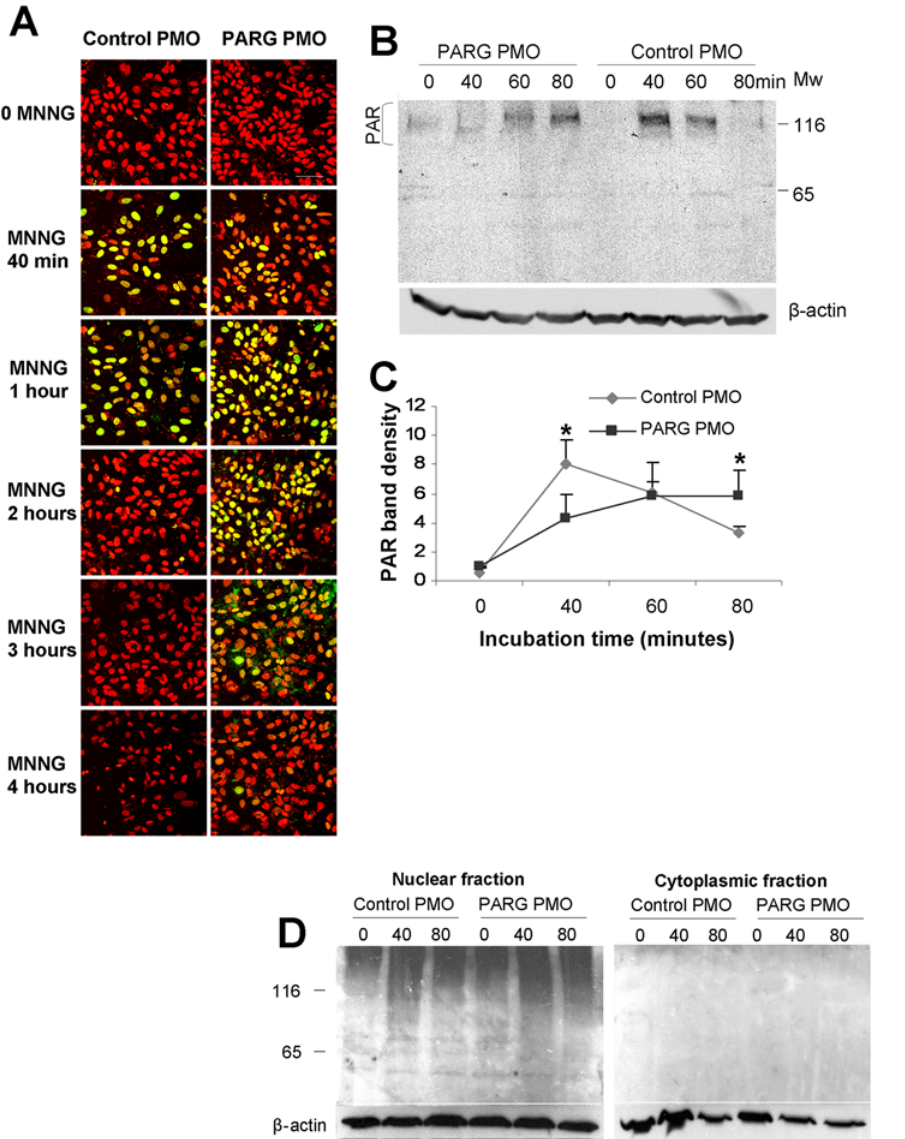
Figure 3. PARG antisense PMO slows PAR degradation. Cultures were incubated with 50 m M MNNG. For observations at time points of 60 minutes or less, incubation with MNNG was continuous. For observations at time points beyond 60 minutes, MNNG was washed out at the 60- minute time point. ( A ) Immunostaining for PAR (green) in astrocytes at the designated time points. Nuclei are counterstained red with propidium iodide, and the images are merged. The cultures treated with antisense PARG PMO show prolonged nuclear PAR immunostaining relative to those treated with control PMO, and show less nuclear condensation at the 4 hour time point. Scale bar=40 m m. Results are representative of 4 independent experiments. ( B ) PAR Western blots from cells treated with MNNG show prolonged elevations in PAR immunoreactivity in the cultures treated with PARG antisense PMO. ( C ) Graph shows quantified data. n=3, *p , 0.05. ( D ) PAR Western blots prepared from nuclear and cytoplasmic cell fractions showed PAR detectable only in the nuclear fraction. These blots are overexposed, relative to the blots shown in Fig. 3B, to